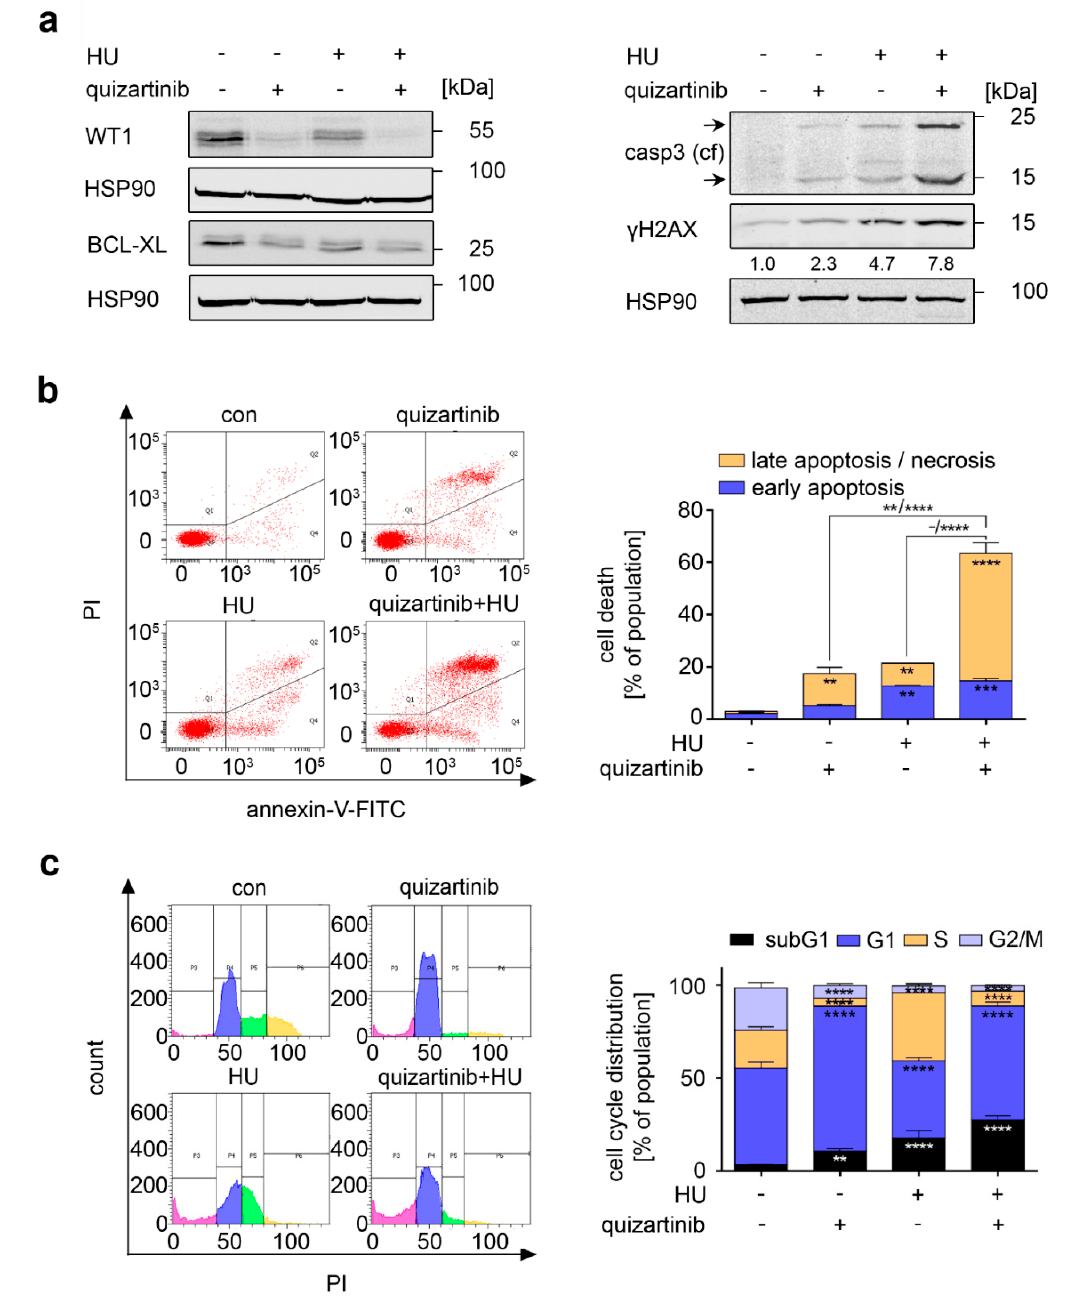
Figure 6. Pro-apoptotic effects of inhibition of FLT3-ITD are more pronounced upon replication stress. ( a ) MV4-11 cells were exposed to 2 nM quizartinib and 0.5 mM hydroxyurea (HU) for 24 h. Immunoblot analysis shows the expression of WT1, BCL-XL; cleaved caspase-3 (casp3 (cf), caspase 3—cleaved form) and γ H2AX; HSP90 serves as loading control—note that each membrane was tested for equal loading with HSP90 and shown are the corresponding data for these experiments. Numbers below γ H2AX show densiometric analyzes of the protein expression normalized to the loading control; protein levels in untreated cells was defined as 1.0. ( b ) Cells treated as in A) were stained with annexin-V and PI and measured by flow cytometry for the induction of early and late apoptosis and necrosis. Left: Representative dot plots are shown. Right: Cell death calculations of annexin and PI stained MV4-11 cells; n = 3 ± SD; two-way ANOVA; Bonferroni’s multiple comparisons test: ** p < 0.01; *** p < 0.001; **** p < 0.0001. ( c ) To analyze the cell cycle distribution, MV4-11 cells treated as indicated were fixed and stained with PI. Left: Exemplary histograms are shown. Right: Cell cycle distribution of these cells; n = 3 ± SD; two-way ANOVA; Bonferroni’s multiple comparisons test: ** p < 0.01; **** p < 0.0001.